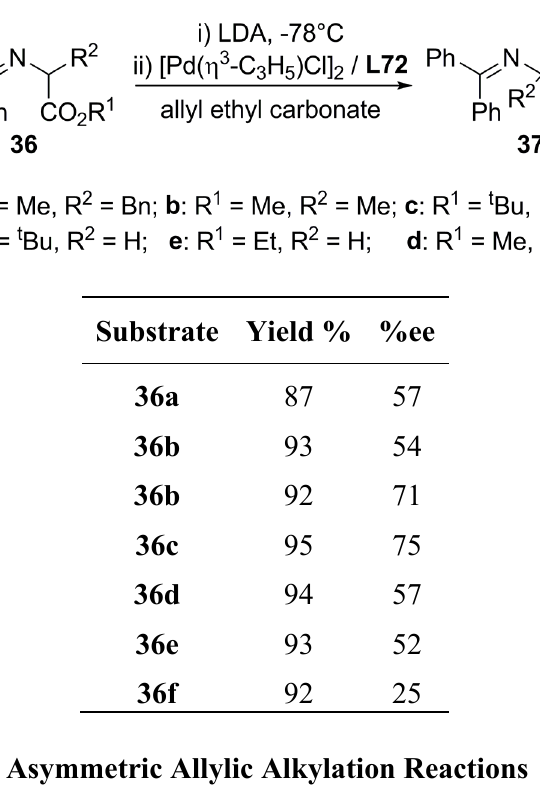
Table 5. Palladium-catalysed asymmetric allylation of different aminoesters with ligand L72